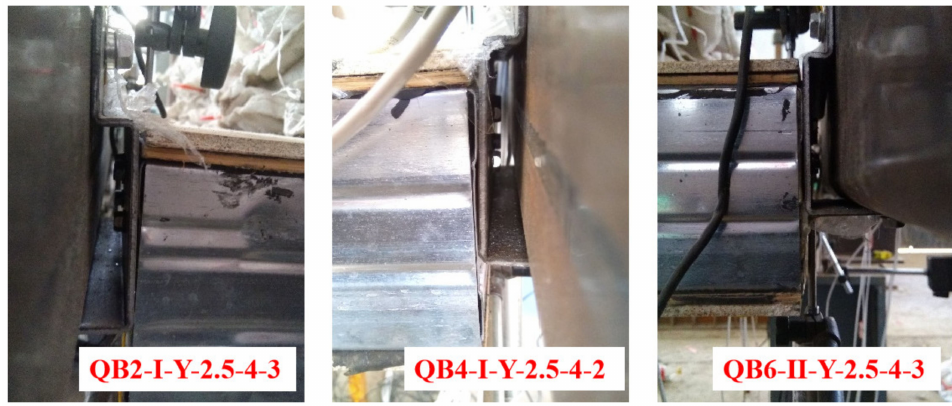
Figure 12. Deformation of special-shaped connectors under applying maximum